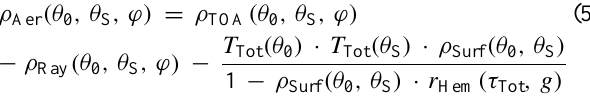
phase function leads to an overestimation or underestima- tion of the AOT. To avoid this problem, recent operational algorithms (Kaufman and Tanre, 1998; Khan et al., 2005; Kokhanovsky et al., 2010) use the best combination LUT with fine and coarse mode aerosol model based on global aerosol climatology. This study is focusing on an improve- ment of the aerosol model to reflect local characteristics and its integration within the retrieval procedure. The aerosol re- trieval based on LUTs described in Sect. 2 for the East-Asian region has been applied for MODIS